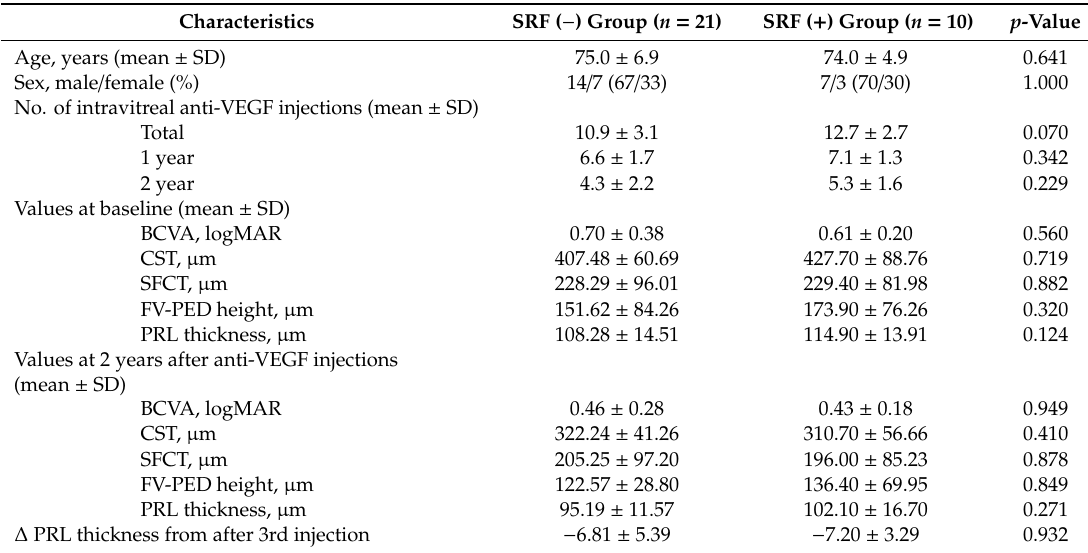
Table 3. Clinical and OCT findings between the SRF ( + ) group and SRF ( − ) group at 2 years after anti-VEGF